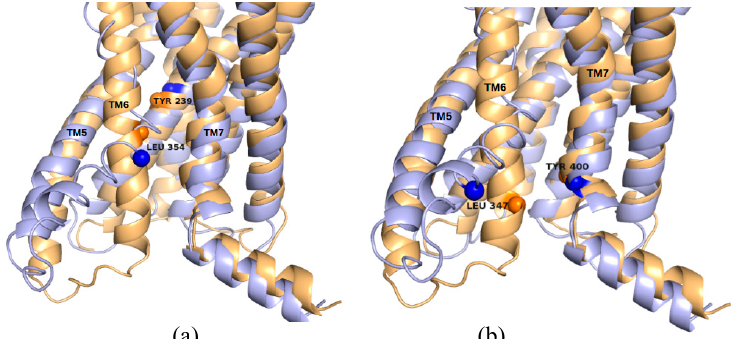
Figure 8. Pairwise distances highly correlated to Δ in GCGR top-ranked sites. ( a ) Y239 and L354, in Site 5; ( b ) L347 and Y400, in Site 6. The distances between these residues contribute the most to the coupling strength of the respective sites. The C α′ s of these residues are shown as spheres, and inactive (light orange) and active (blue) conformations are superposed, to highlight the conformational changes of the sites upon receptor activation.